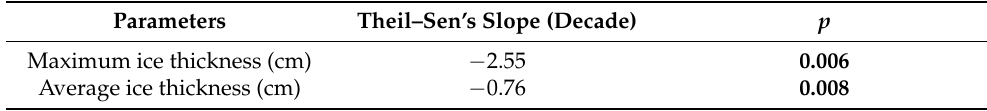
Figure 10. Maximum and average ice thicknesses for the winter 1951/1952–2017/2018. The lines are trends of ice thicknesses ( p < 0.05). Table 6. Trends of seasonal ice